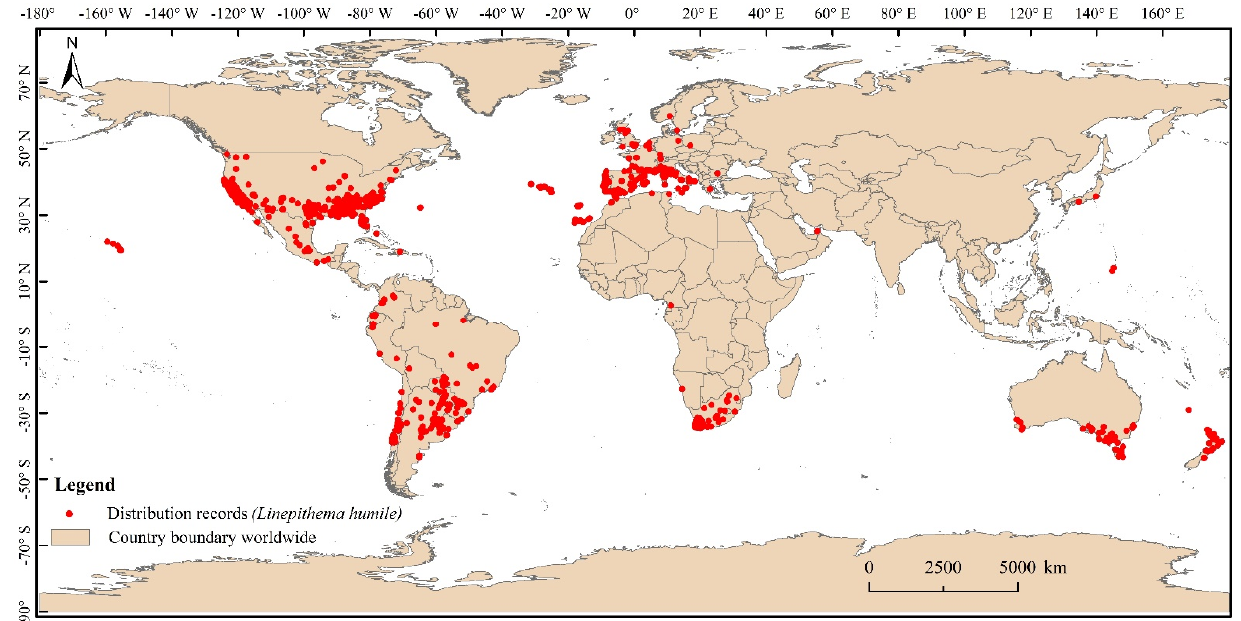
Figure 1. Global occurrence records of the Linepithema humile .